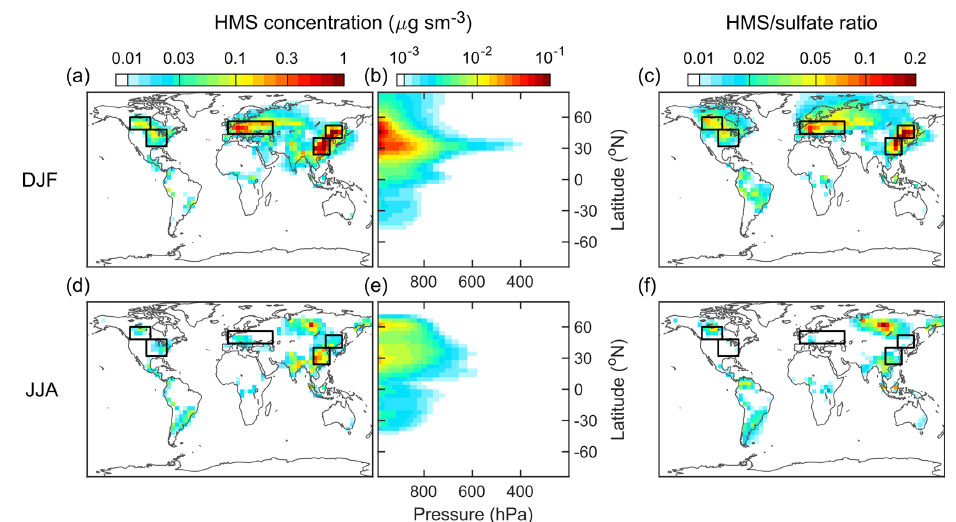
Figure 4. Distributions of HMS concentrations and the molar ratios of HMS to sulfate modeled by the default simulation. Top and bottom panels show results for DJF (December–January–February) and JJA (June–July–August), respectively. (a) , (c) , (d) , and (f) are the horizontal distributions in the surface layer. (b) and (e) are the vertical distributions of the zonal averages from surface to 200hPa. The concentration unit is µgsm − 3 , where 1sm 3 equals 1m 3 at 273.15K and 1013.25hPa. The color bars are not linear and differ in the three columns. The same color bars are used for each pair of the top and bottom panels. The black-outline boxes indicate the three regions selected for quantitative